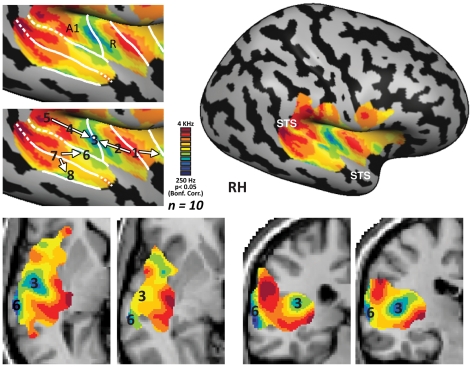
Multiple mirror-symmetric cochleotopic maps in the right hemisphere of the human auditory cortex.Group (Exp. 1, n = 10) relative frequency preference map is presented in a lateral view of the inflated right cortical hemisphere of the standard MNI brain, exposing the entire cochleotopic organization of the multiple iso-frequency bands (STG – Superior temporal gyrus, STS – Superior temporal sulcus). On the left panels, the auditory cortex region is magnified, showing Exp. 1 relative frequency preference map on the cortical surface. The estimated border between the putative mirror- symmetric cochleotopic maps is indicated (white line) in the lowest and highest frequency tones which represent the mirror-symmetry flipping lines between the homologues of A1 and R (and possibly, anterior to it, RT) in the core auditory cortex, and between multiple additional cochleotopic fields. Numbers indicate points along the cochleotopic gradients (similar to those depicted in
Fig. 6
, from which raw time-courses of activation were sampled), with white arrows demonstrating the gradient direction in each filed. On the lower panels, the same gradients are depicted in volume views in horizontal (z = 4, 0), and coronal (y = −28, −22) slices, numbered similarly to the surface view (for demonstrative and orientation purposes only), to enable the identification of the same gradients in the three-dimensional based views.